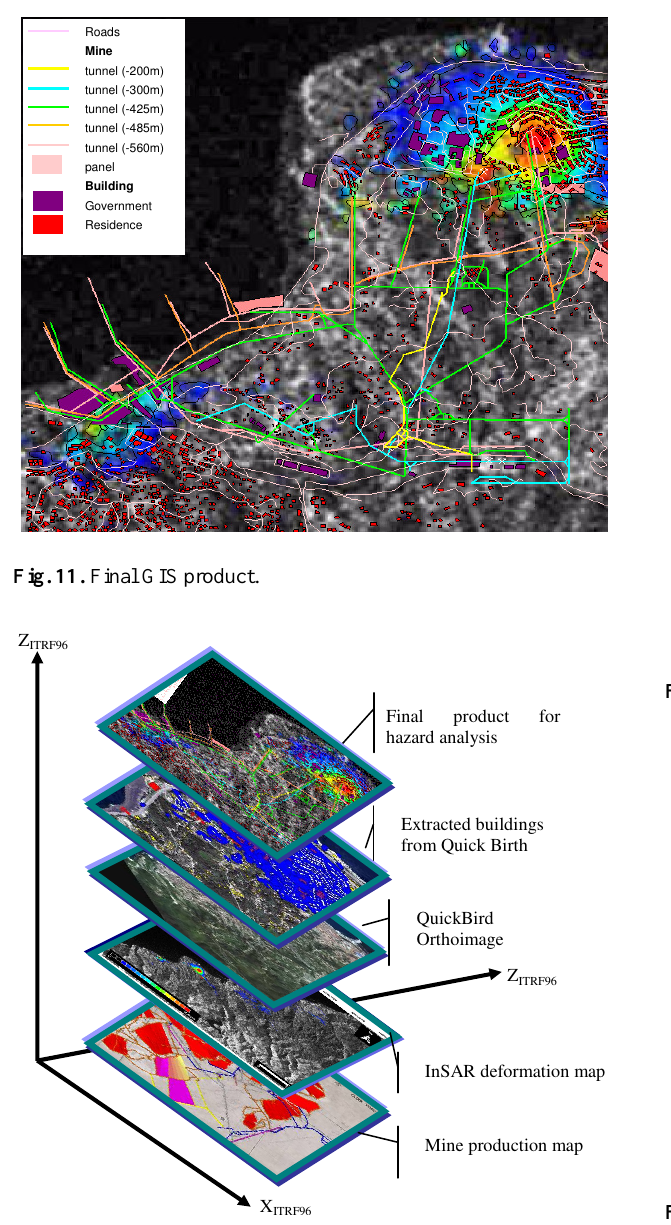
Figure 14. An example of the damaged buildings documented on site (from a high school) Fig. 14. An example of the damaged buildings documented on site (from a high